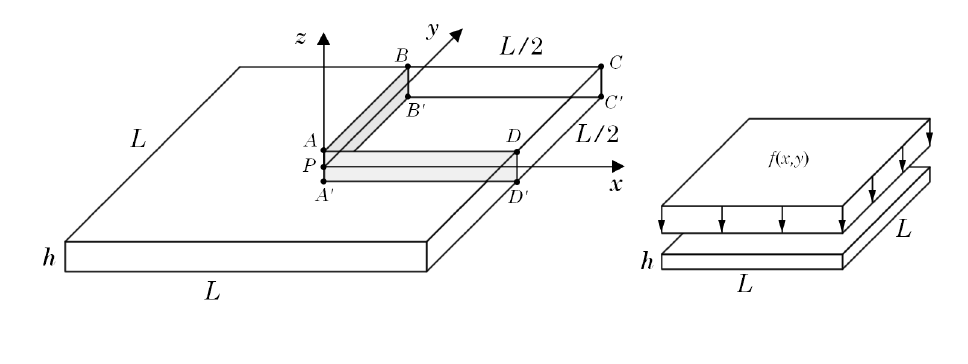
Figure 3. Square plate representation showing the geometric properties, the symmetry assumption and the uniform distributed load considered in all